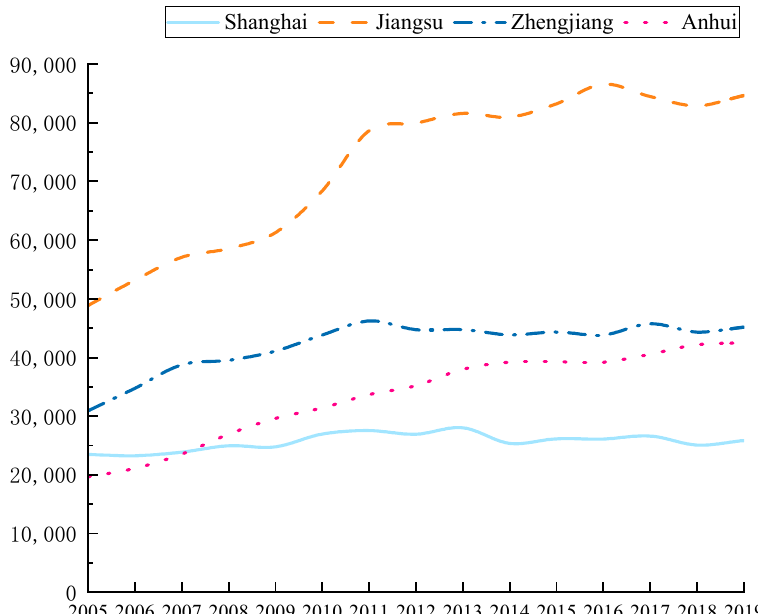
Figure 3. Total carbon emissions of provinces in the Yangtze River Delta region from 2005 to 2019.